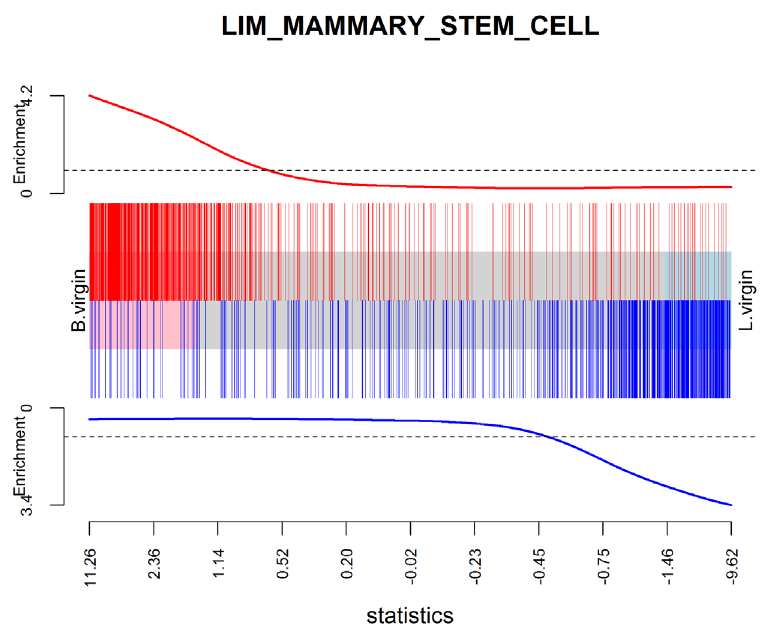
Figure 10. Barcode plot showing strong enrichment of mammary stem cell signature in the stem cell vs luminal cell comparison. Red bars show up signature genes, blue bars show down genes. The worms show relative